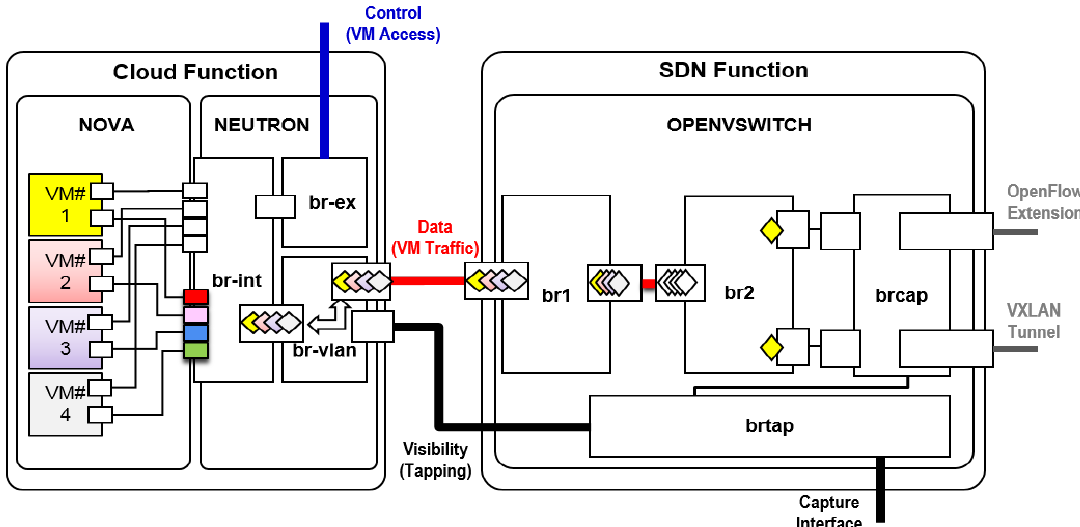
Figure 7. Hyper-converged SmartX Box Virtualized Cloud and SDN